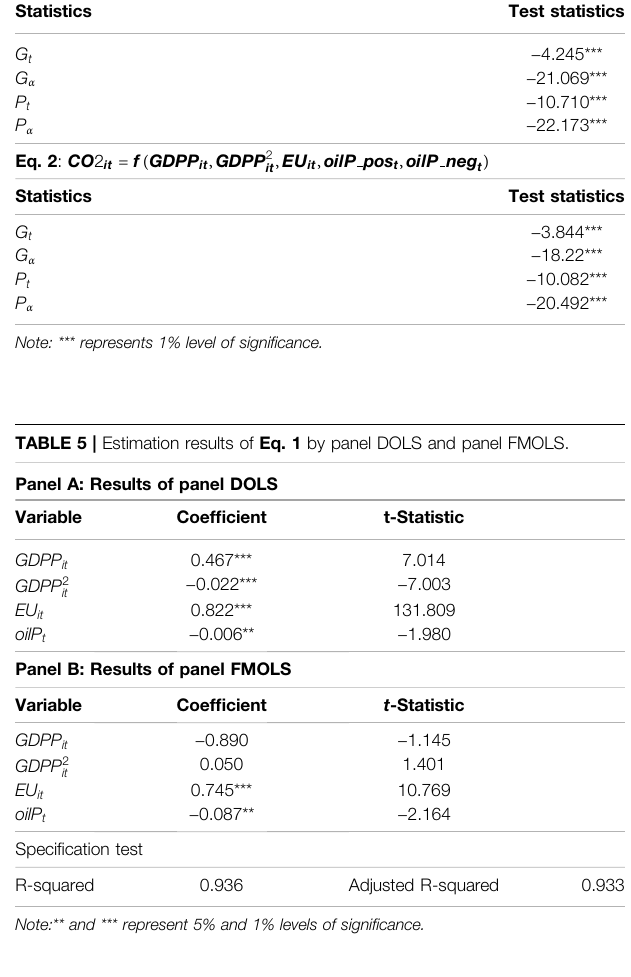
Panel A: Eq. 1: CO2 it (cid:1) f ( GDPP it , GDPP 2 it , EU it , oilP t